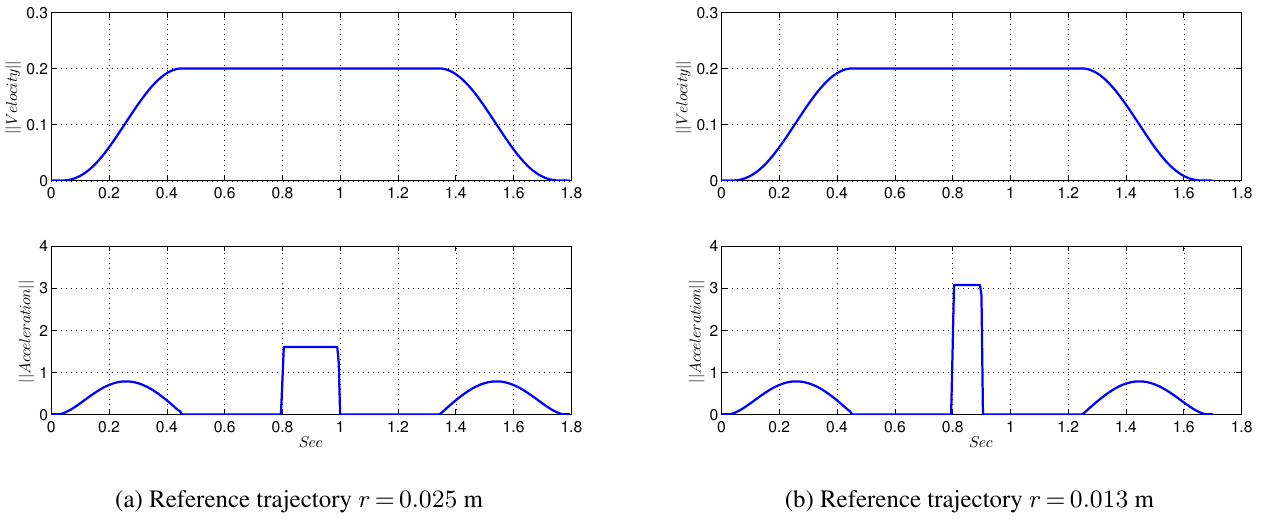
Fig. 3: The norm of the velocity (in m/s) and the acceleration (in m/s 2 ) of reference trajectories. Figure 3. The norm of the velocity (in ms − 1 ) and the acceleration (in ms − 2 ) of reference trajectories.